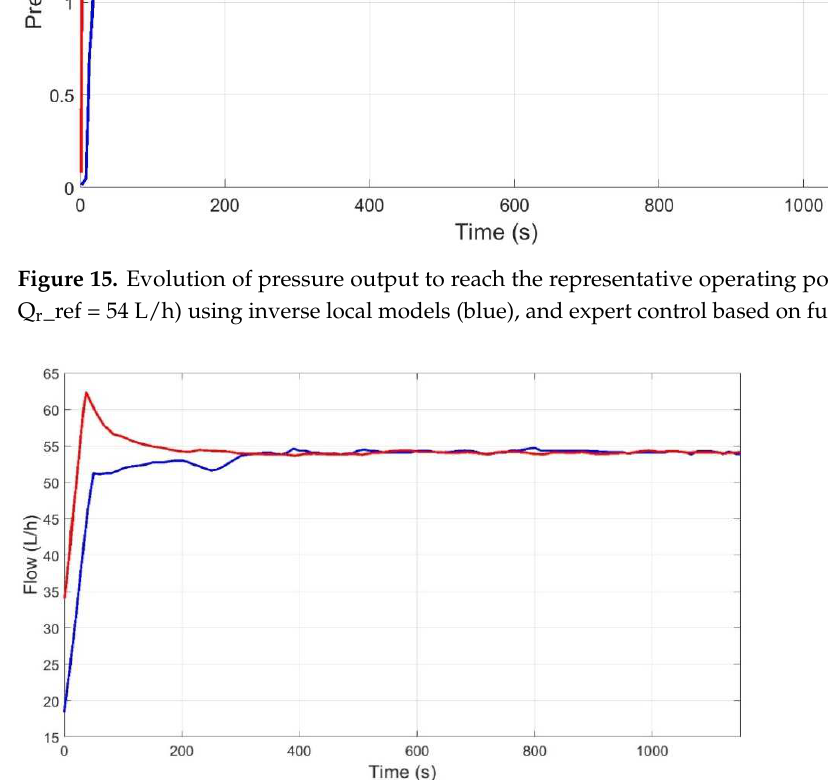
Figure 16. Evolution of flow output to reach the representative operating point (P_ref = 2 bar, Q r _ref = 54 L/h) using inverse local models (blue), and expert control based on fuzzy logic (red).